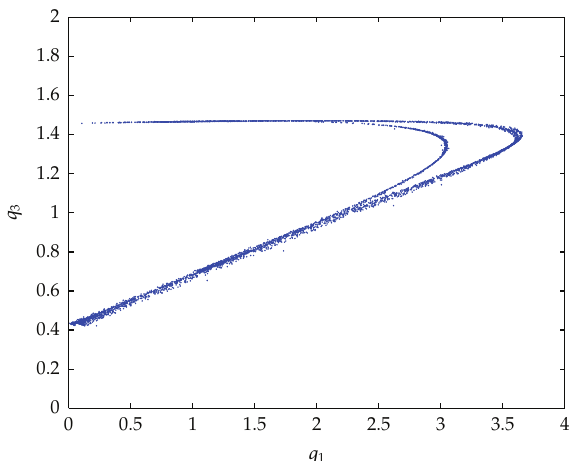
Figure 9: Strange attractor when β (cid:7) 0 . 2 ,α (cid:7) 23 . 1.